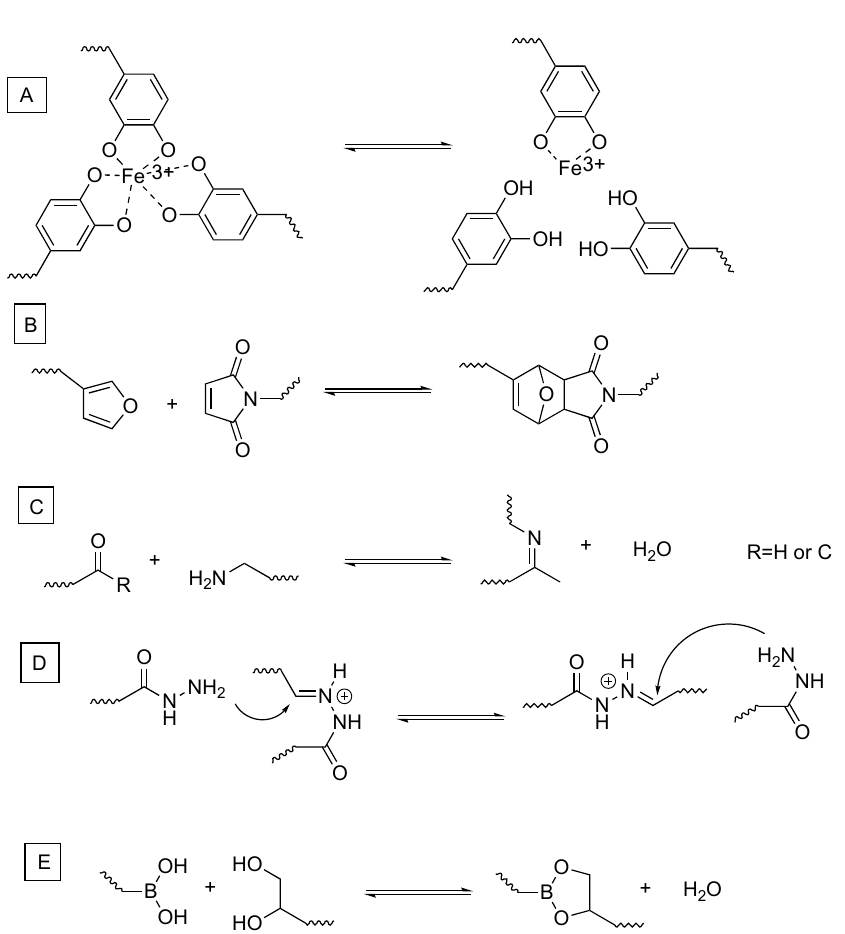
Figure 2. Schematic representation of reversible covalent bonds. ( A ): catechol-Fe chemistry; ( B ): furan-maleimide as example of cycloaddition reactions; ( C ): imine/enamine formation; ( D ): dynamic acylhydrazone exchange reaction; ( E ): boric ester formation and hydrolysis.